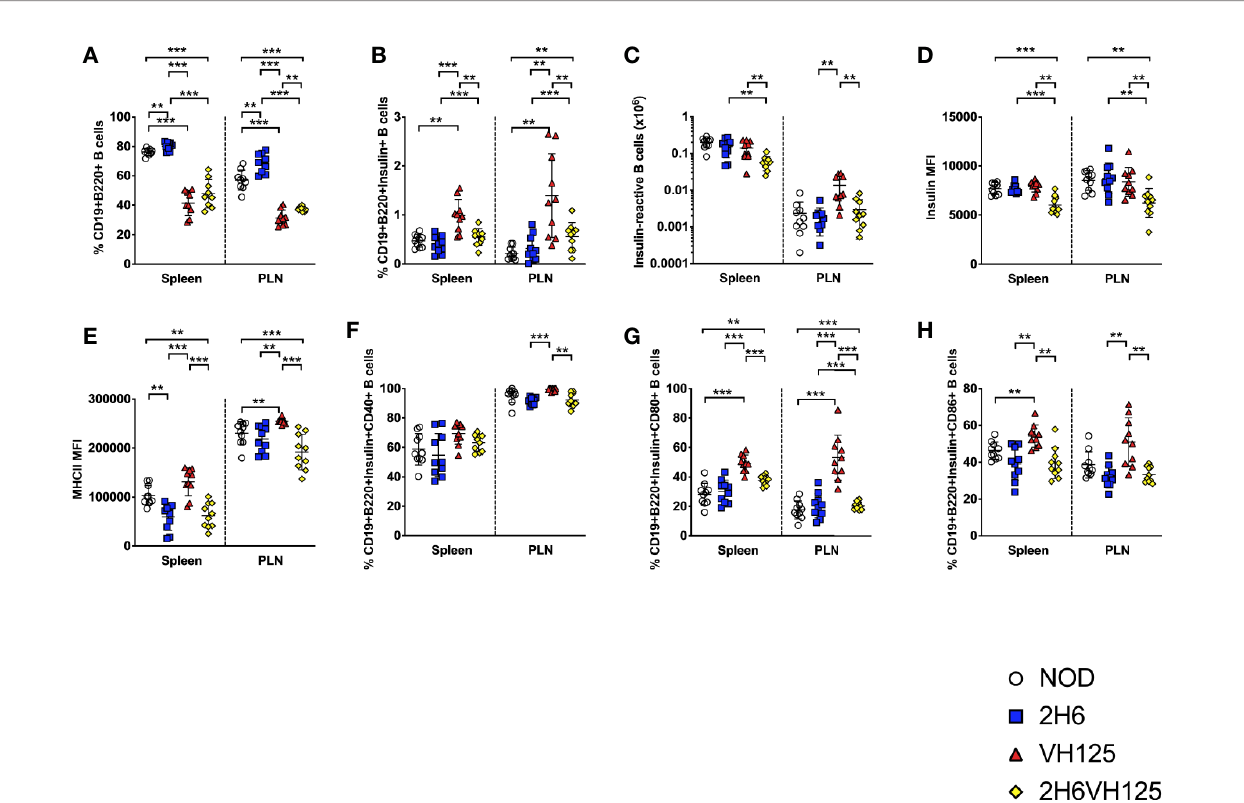
FIGURE 2 | The 2H6 TCR transgene strongly reduces frequency of insulin-reactive VH125 B cells and their costimulatory molecule expression. Splenocytes and cells from the pancreas draining lymph nodes (PLN) were harvested from 8-week-old mice and stained using antibodies for fl ow cytometry. (A) % of live single CD19+B220+TCR b - B cells. (B) % of insulin-reactive B cells identi fi ed by binding to insulin-FITC in CD19+B220+ B cells gated from (A) . (C) Absolute number of Insulin-reactive B cells. (D, E) Mean fl uorescent intensity (MFI) of insulin-FITC and MHCII (IA g7 ), gated within the insulin-reactive B cells in (B) . (F – H) % of CD40, CD80, and CD86 gated within the insulin-reactive B cells. Data were generated from 10 individual mice pooled from 4 to 5 independent experiments. Data from left to right: NOD, 2H6, VH125, and 2H6VH125 are shown in this order in each plot. Data from NOD mice are shown as a non-transgenic mouse comparison. Data were assessed for signi fi cance using multiple T tests and FDR correction. **P < 0.001, ***P <